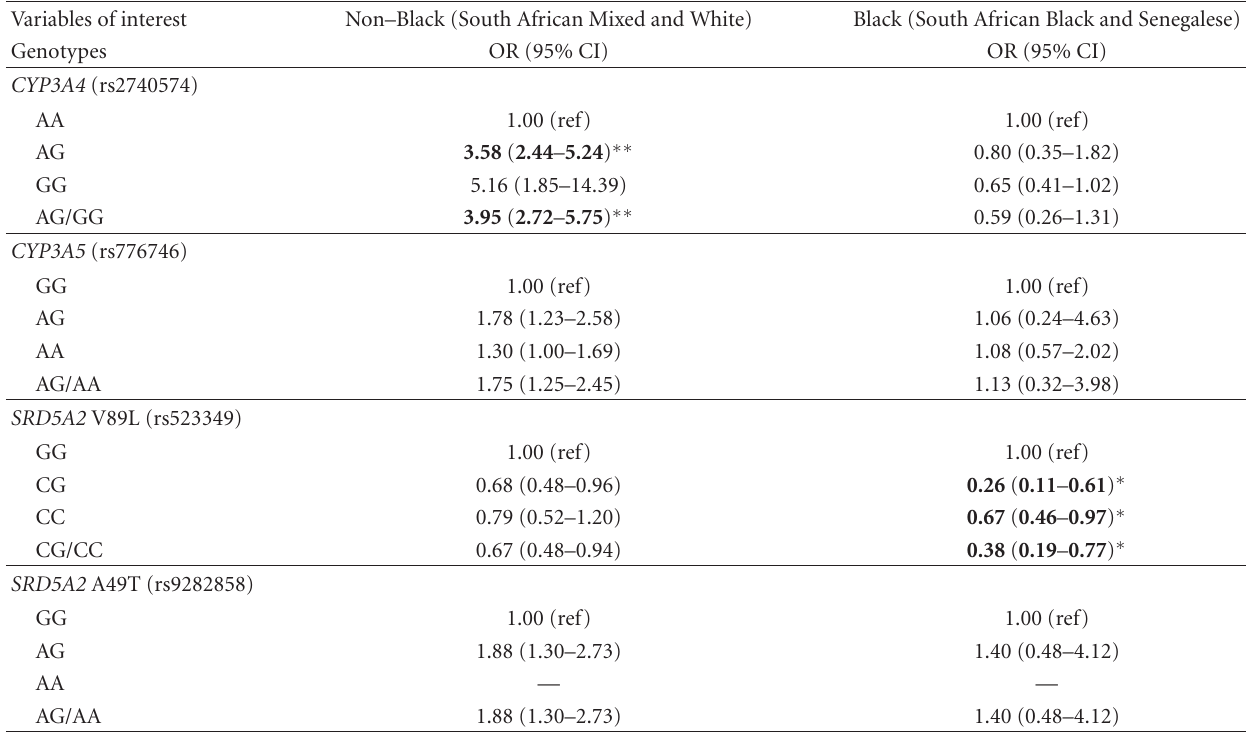
Table 5: Case-control genotype associations with prostate cancer by non-Black and Black men (adjusted for age). Variables of